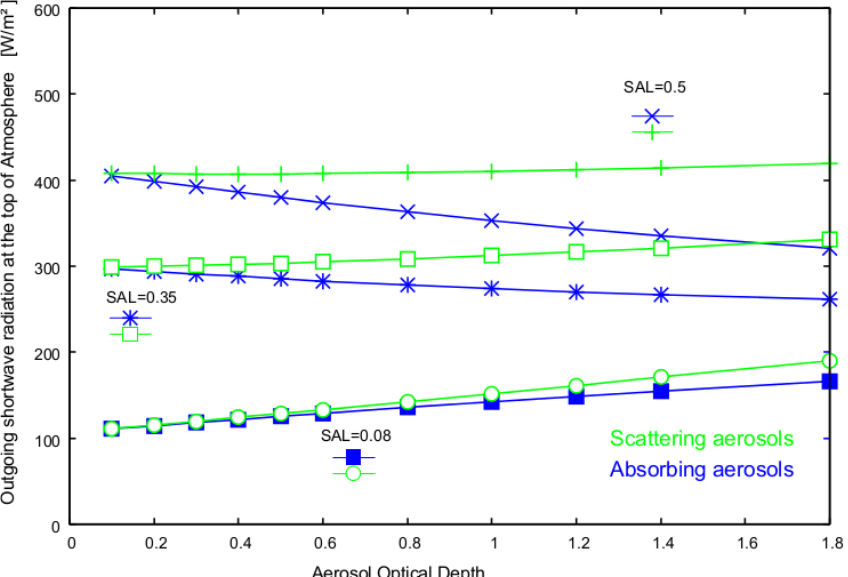
Figure 7. Results of the radiative transfer modeling with libRadtran for US-standard atmosphere, 335 DU ozone, 15 mm water vapor for scattering aerosols (ssa = 0.99) and urban (absorbing) aerosols (ssa ca. 0.8). For absorbing aerosols the increase of the aerosol optical depth leads to a significant decrease of the planetary reflection for bright surfaces. This behavior is quite contrary for scattering